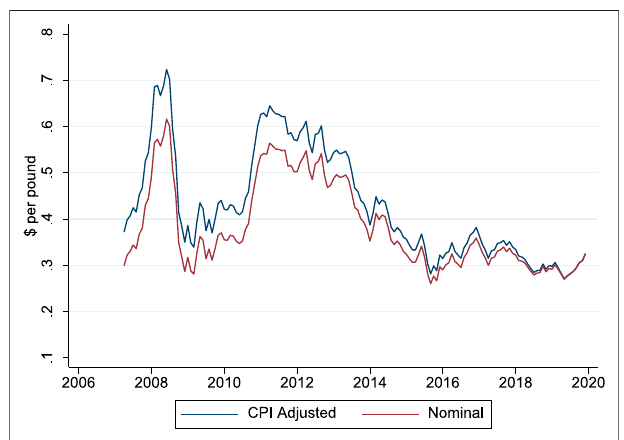
FIGURE 1 | Soybean oil prices, April 2007 to December 2019. Note: Figure 1 provides nominal and consumer price index (CPI) adjusted prices expressed as of the end of